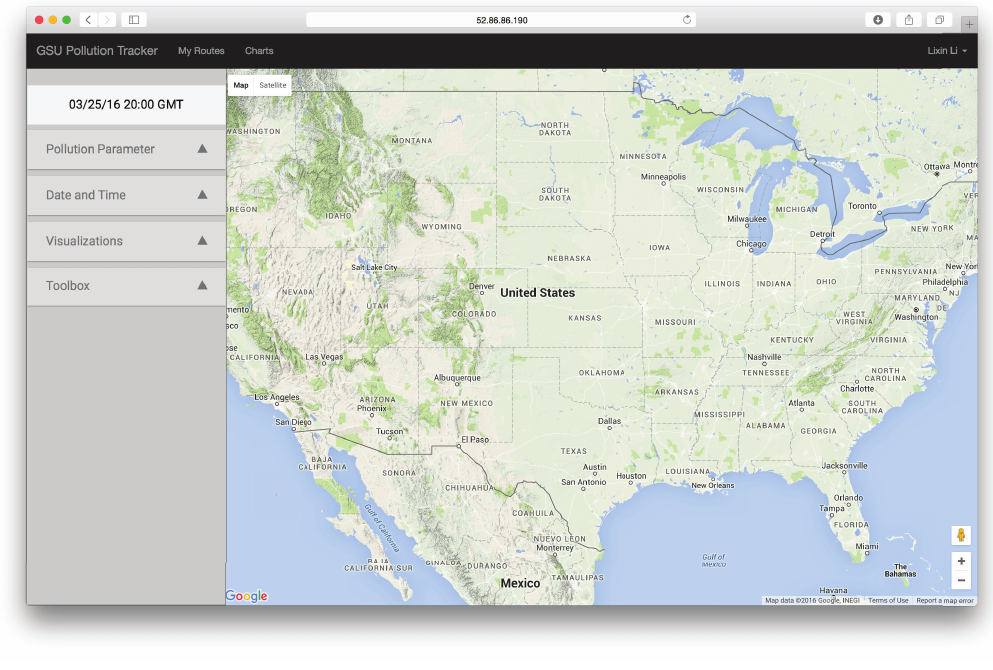
Figure 8. Web application. Map overview screen after logging in.